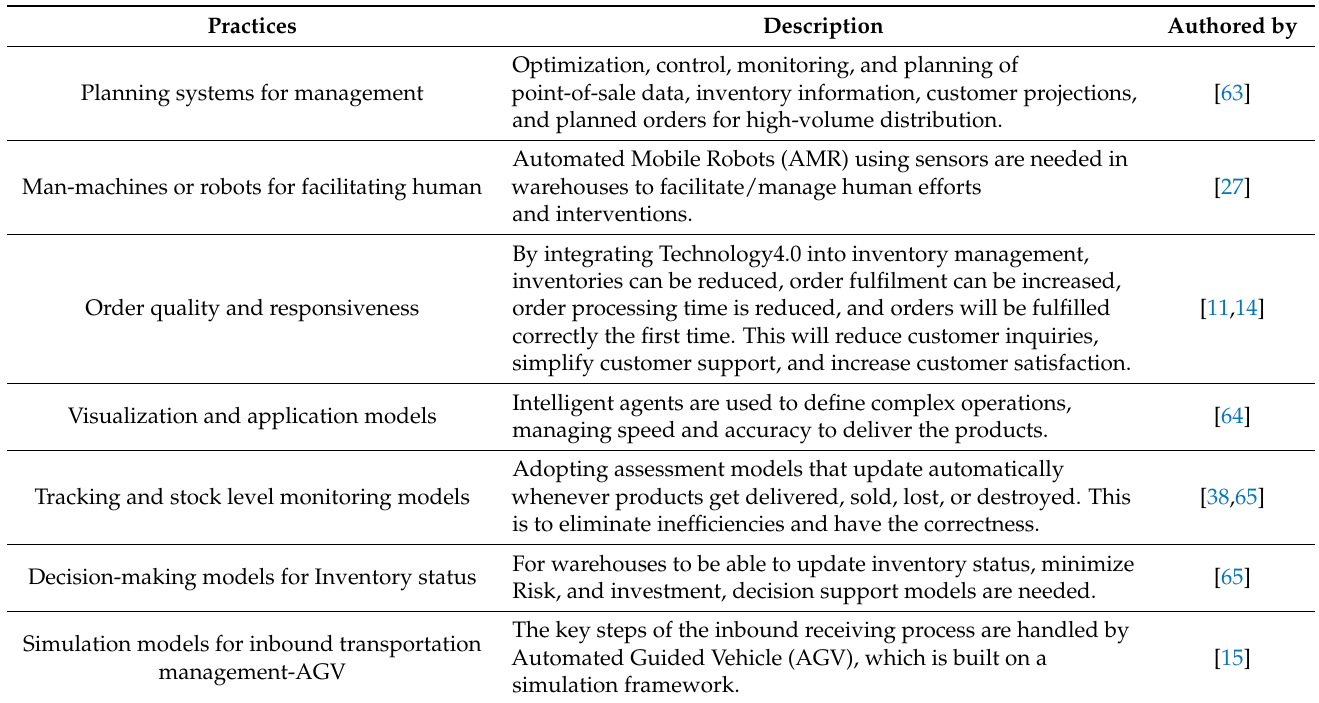
Table 5. Technology 4.0 driven